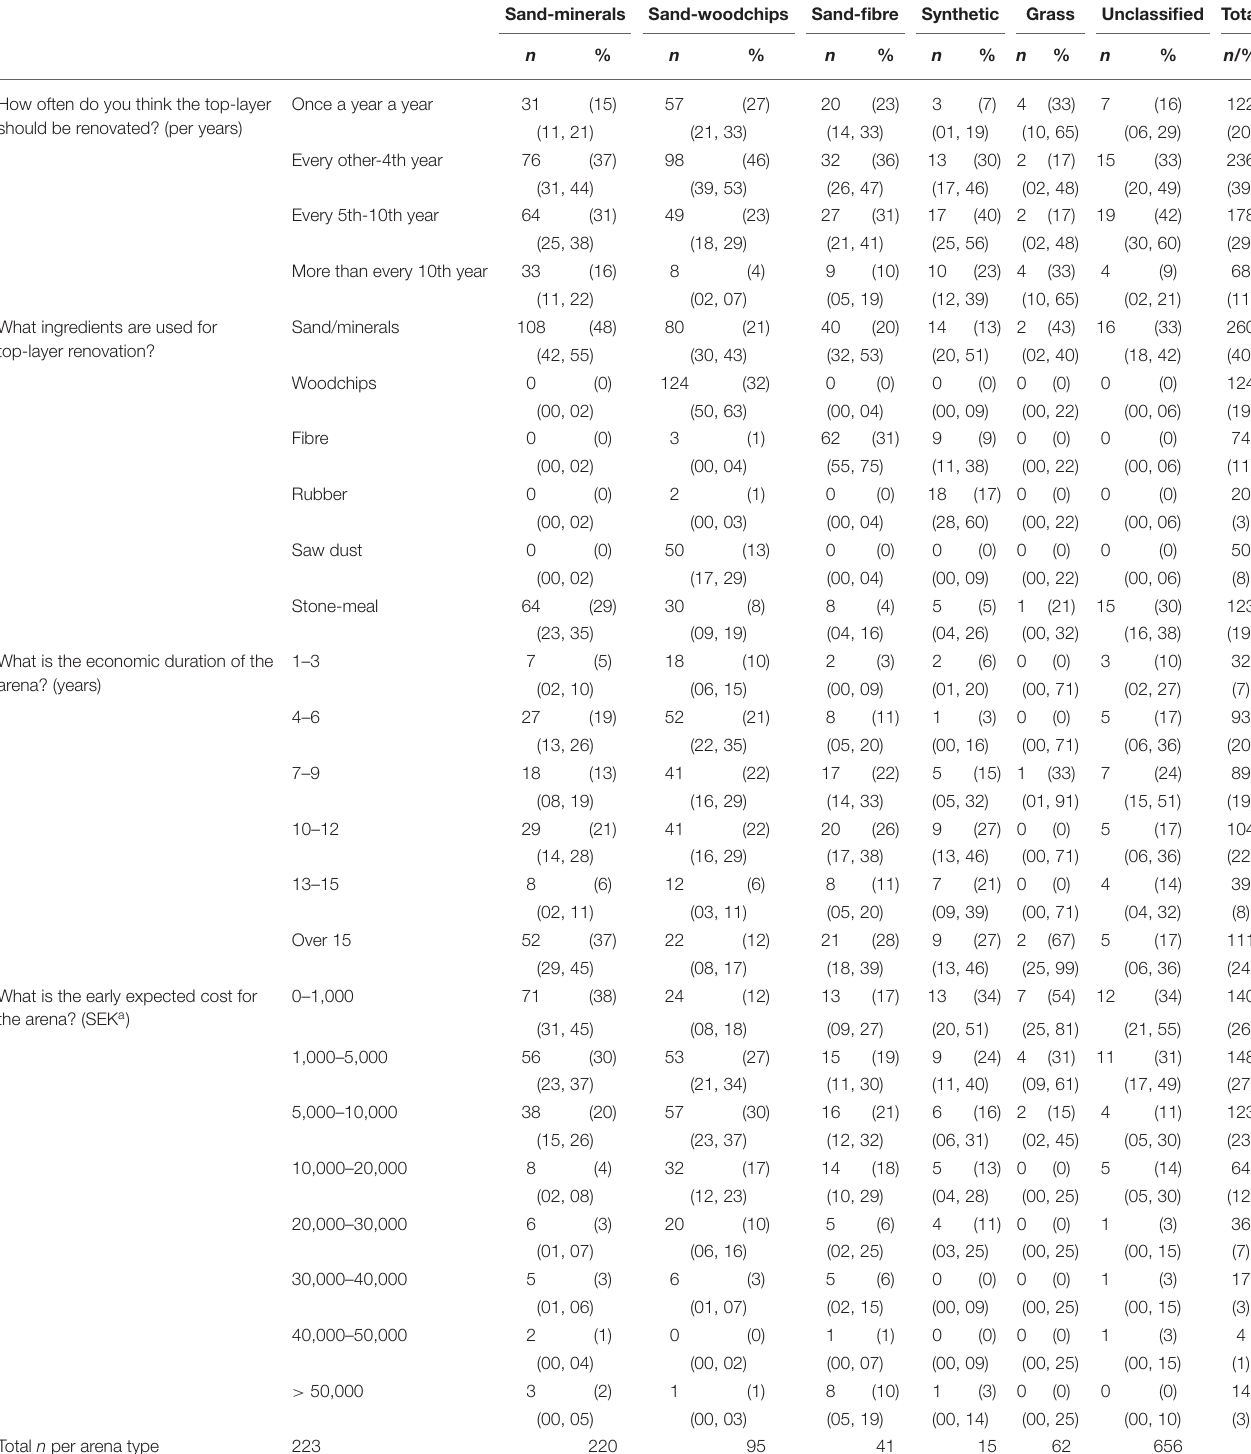
TABLE 7 | Plans for long-term maintenance of the